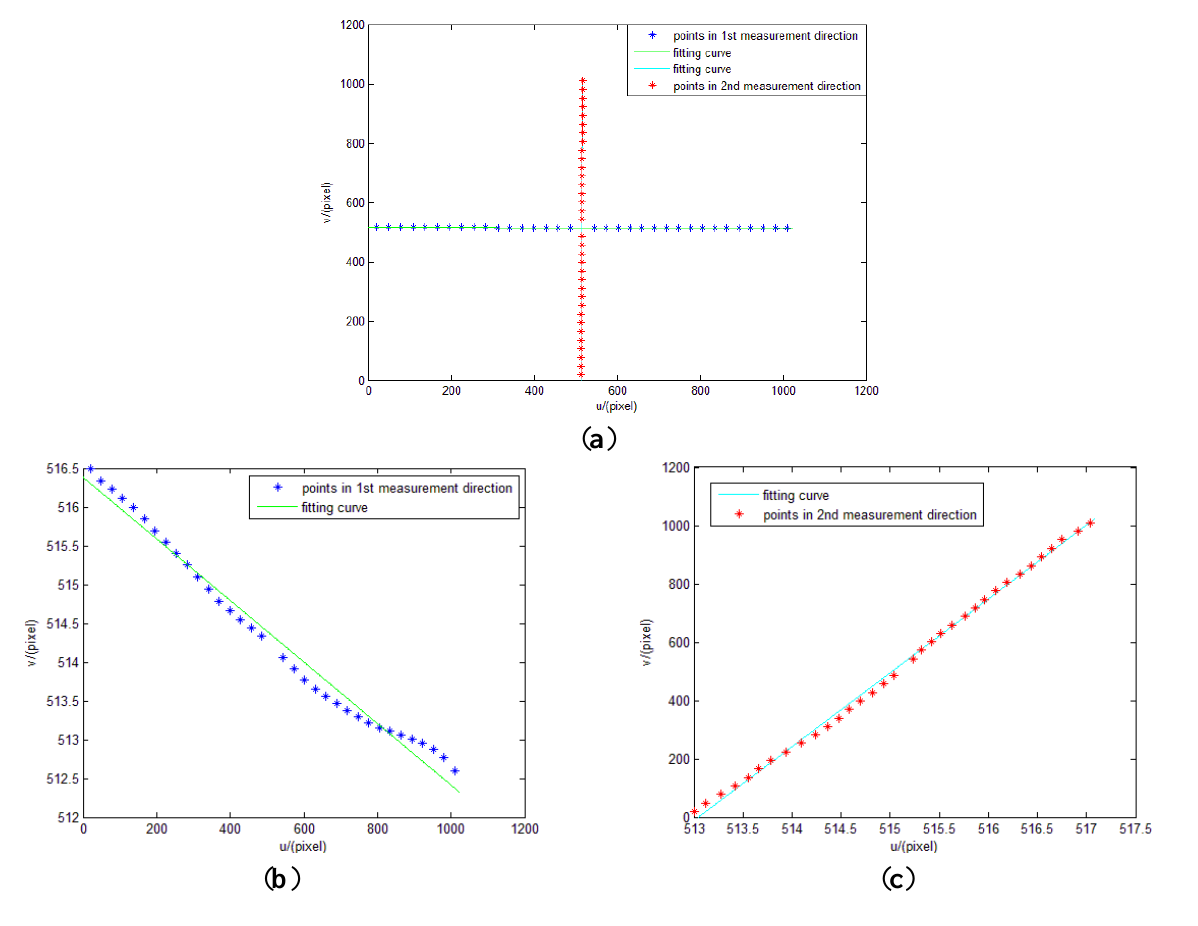
Figure 21. Measurement points and linear fitting curve ( a ). ( b ) and ( c ) show the two fitting curves